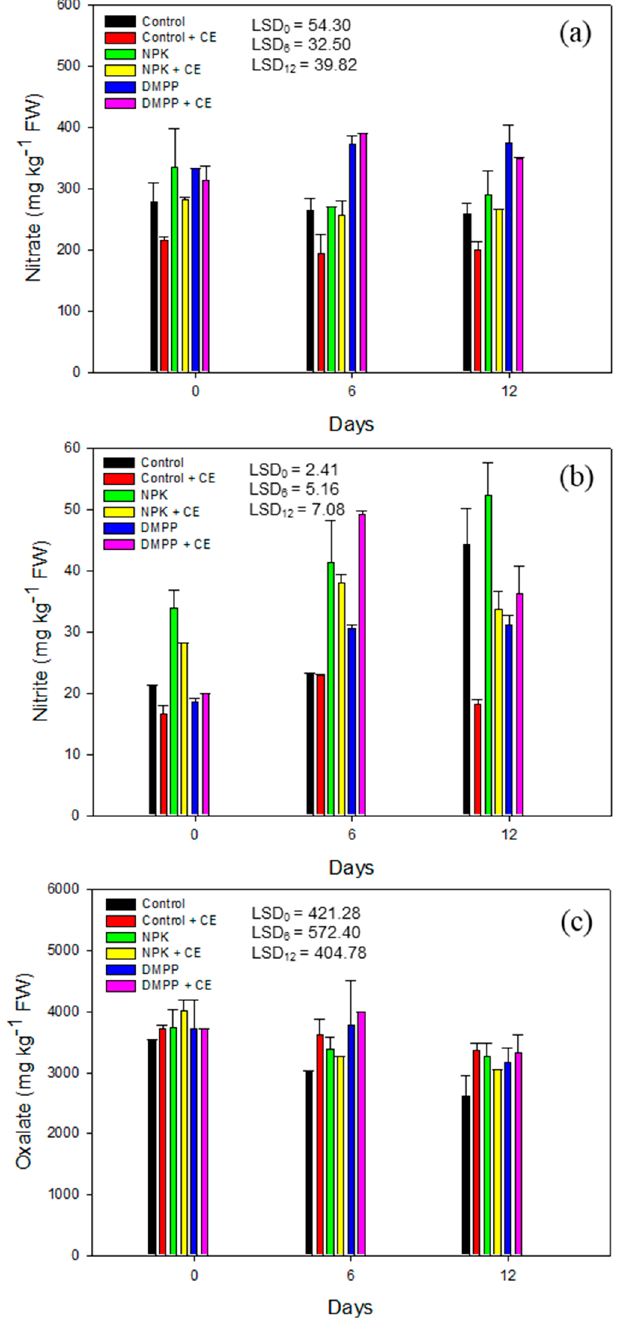
Figure 1. The nitrate ( a ), nitrite ( b ), and oxalate ( c ) content of fresh spinach leaves at 0, 6, and 12 days of storage at 4 °C. Control; Control + CE, control with compost extract; NPK, inorganic NPK fertilizer 15-15-15; NPK + CE, inorganic NPK with compost extract; DMPP, ENTEC Nitrofoska ® plus the nitrification inhibitor (IN) 3,4-dimethylpyrazole phosphate (DMPP); DMPP + CE, the nitrification inhibitor (IN) with compost